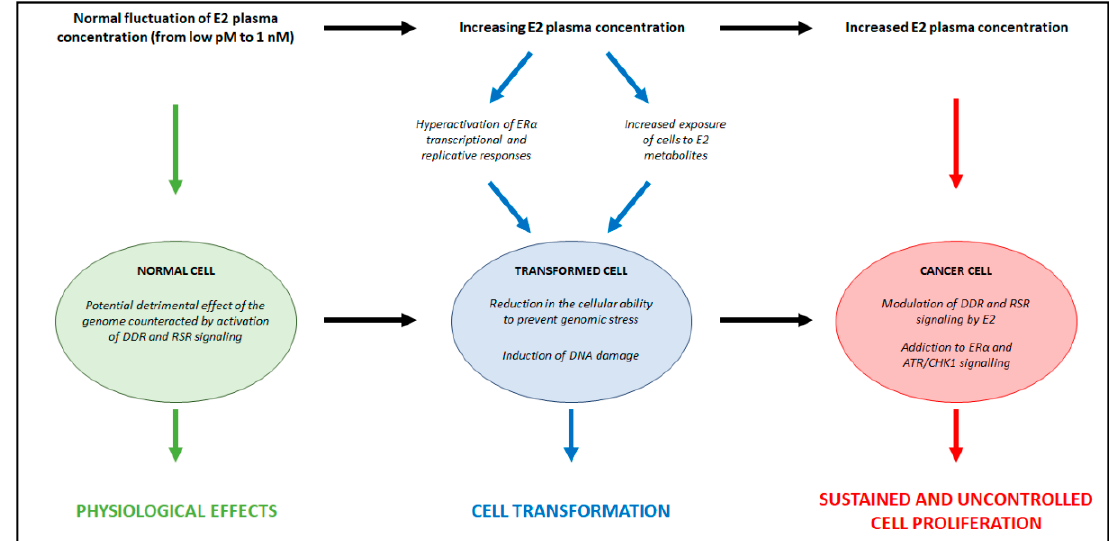
Figure 6. Proposed mechanism for the dual role of E2 in balancing DNA damage and genome integrity. Green, blue and red arrows indicate the effect in the specific cellular context. Black arrows indicate transitions between the specific cellular contexts. For details, see the text. 17 β -estradiol (E2); estrogen receptor α (ER α ); Ataxia Telangiectasia and Rad3-Related Protein (ATR); Checkpoint Kinase 1 (Chk1); DNA damage response (DDR); Replication stress response (RSR).